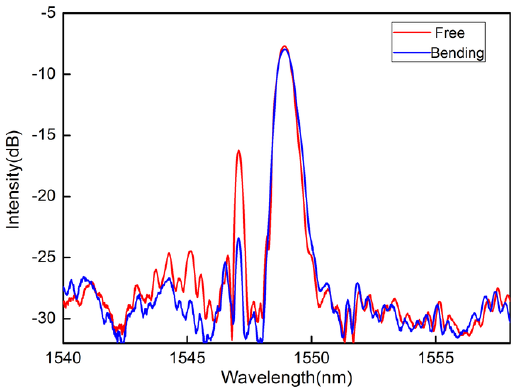
Figure 3. Spectra of QCF-FBG with and without bending.